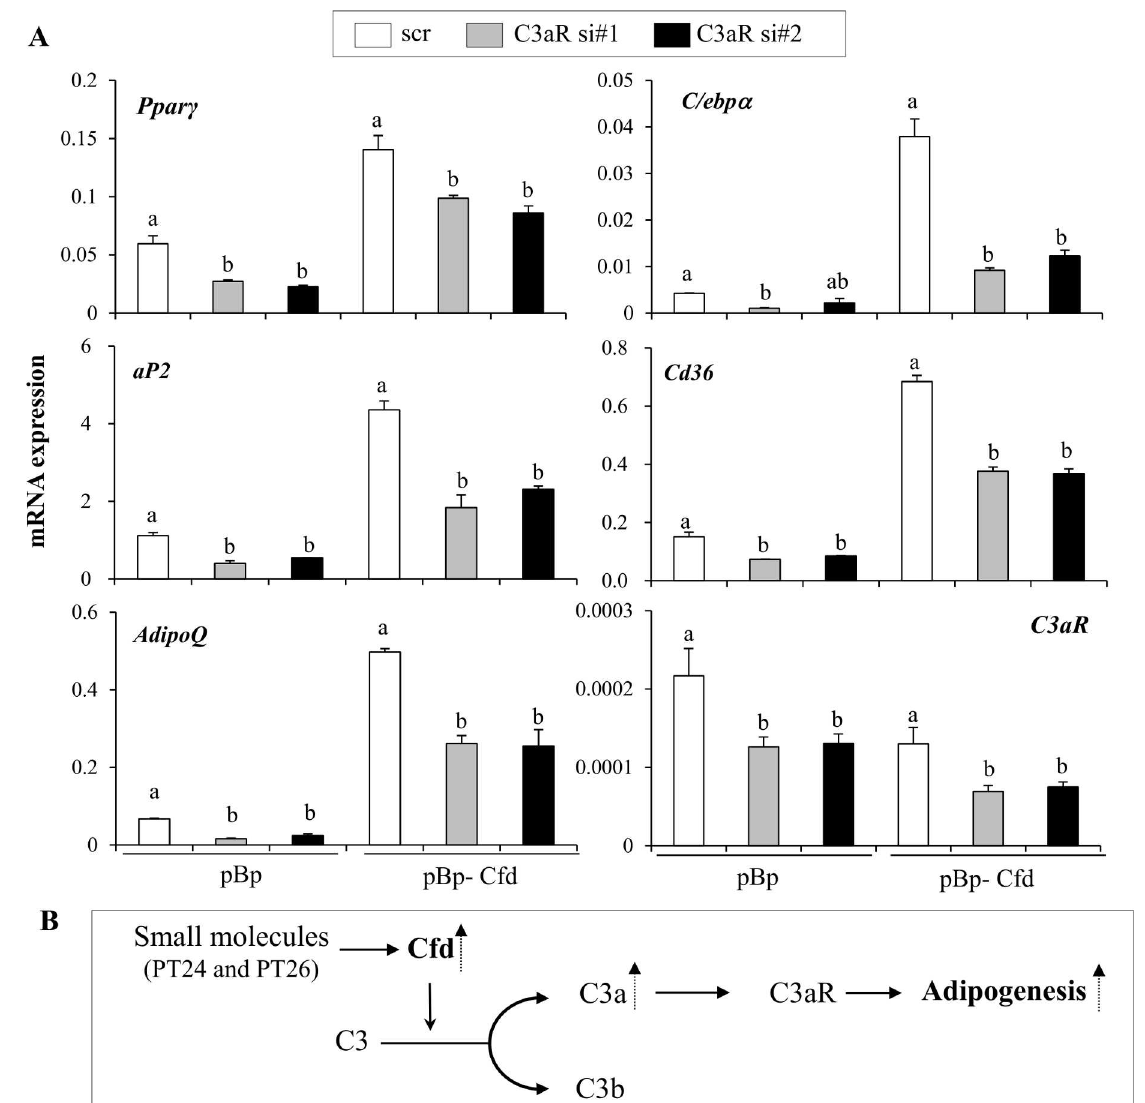
Fig 7. C3aR signaling is requiredfor adipogenicpotential of Cfd overexpressing cells. ( A ) The increased adipogenic potentialof Cfd expressing cells is blocked by silencingC3aR expression. Controlempty vector (pBp)or Cfd stably overexpressing 3T3-L1cells (pBp-Cfd)were transiently transfected with siRNAs targetingC3aR and differentiated into adipocytesfor 6 days. Expression of adipocytemarkerswas assessed by real time PCR. Data are presentedas means +/- s.d. and are representative of two independent experiments. Each independent experimentwas carriedout in triplicate.Statistical significance differences were determinedusing one- way ANOVA and the Student-Newman-Keuls test.Different letterat each samplesare significant( P < 0.05).( B ) A schematic modelof small molecules-induced Cfd in C3a-C3aR